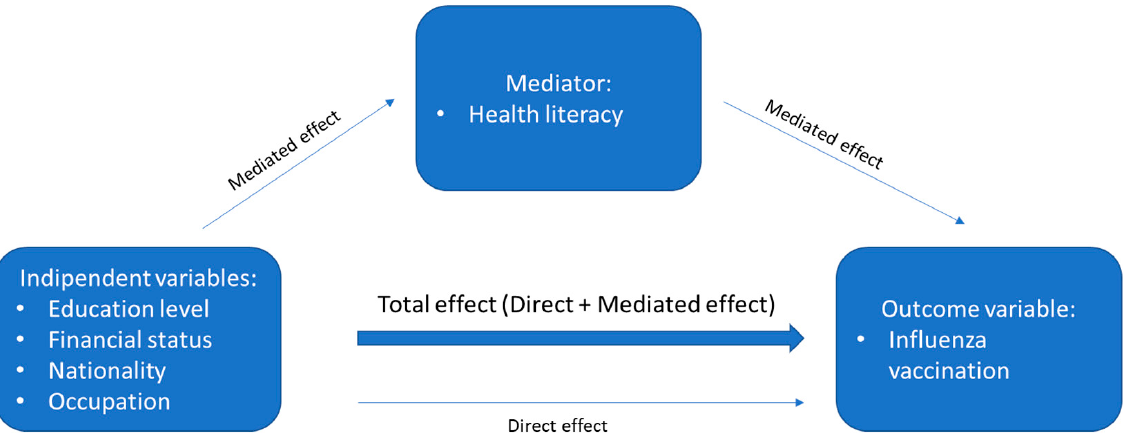
Figure 1. Hypothesized causal pathway of HL as a mediator of the association between socio-economic status and influenza vaccination uptake.